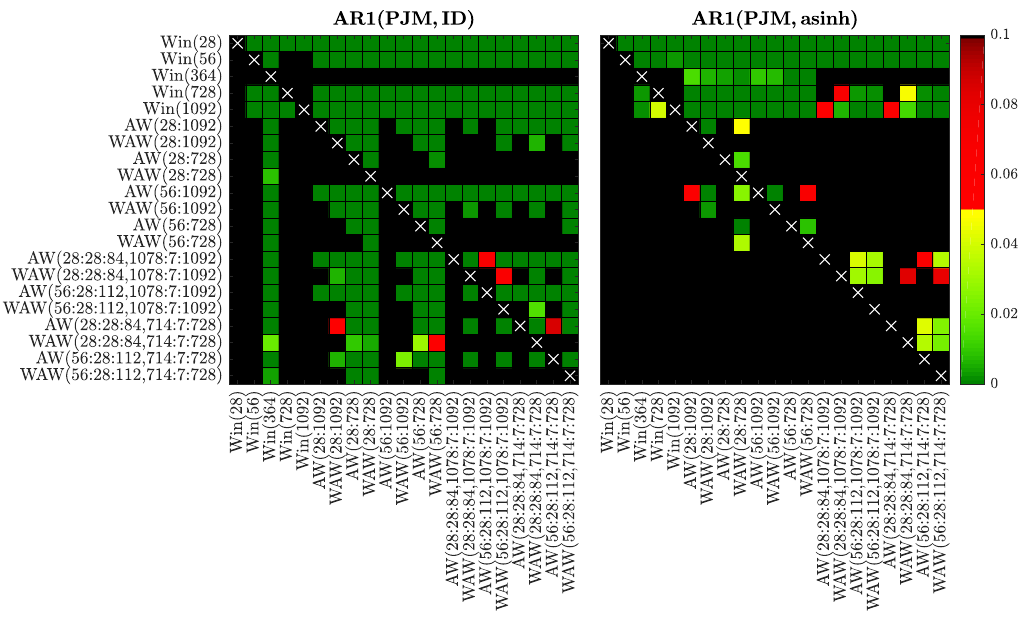
Figure 12. Results of the CPA test for selected window sets and the AR1 model fitted to raw ( left ) or asinh -transformed ( right ) PJM prices. We use a heat map to indicate the range of the p -valuesthe closer they are to zero ( → dark green) the more significant is the difference between the forecasts of a set on the X -axis (better) and the forecasts of a set on the Y -axis (worse).